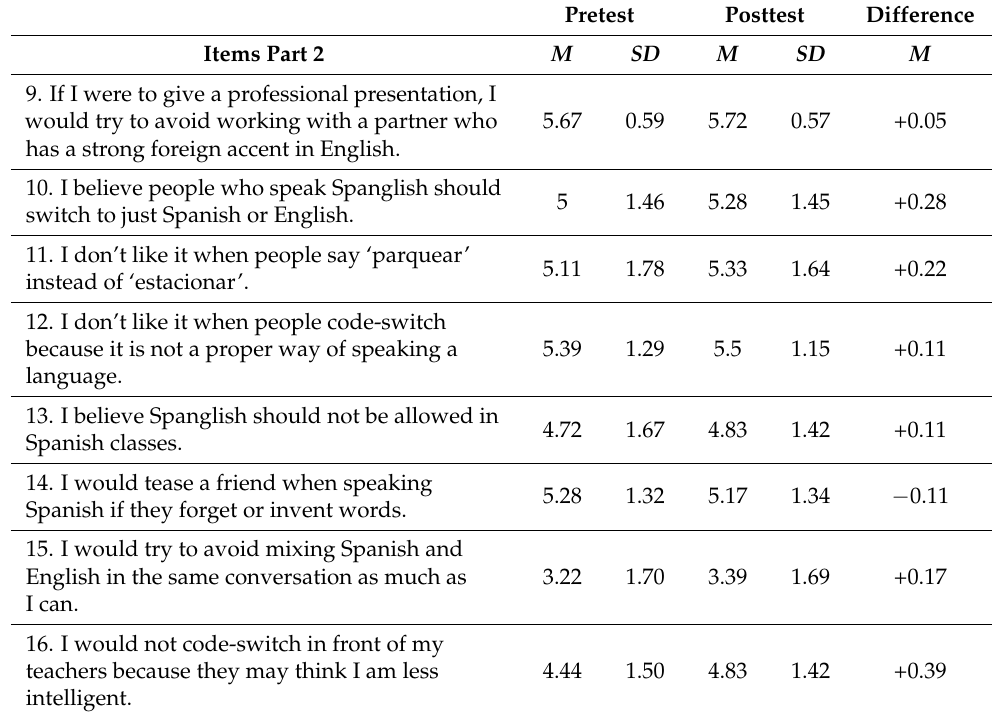
Table 4. Mean and Standard Deviation Results for CLA Questionnaire Part 2 ( N = 18). Pretest Posttest